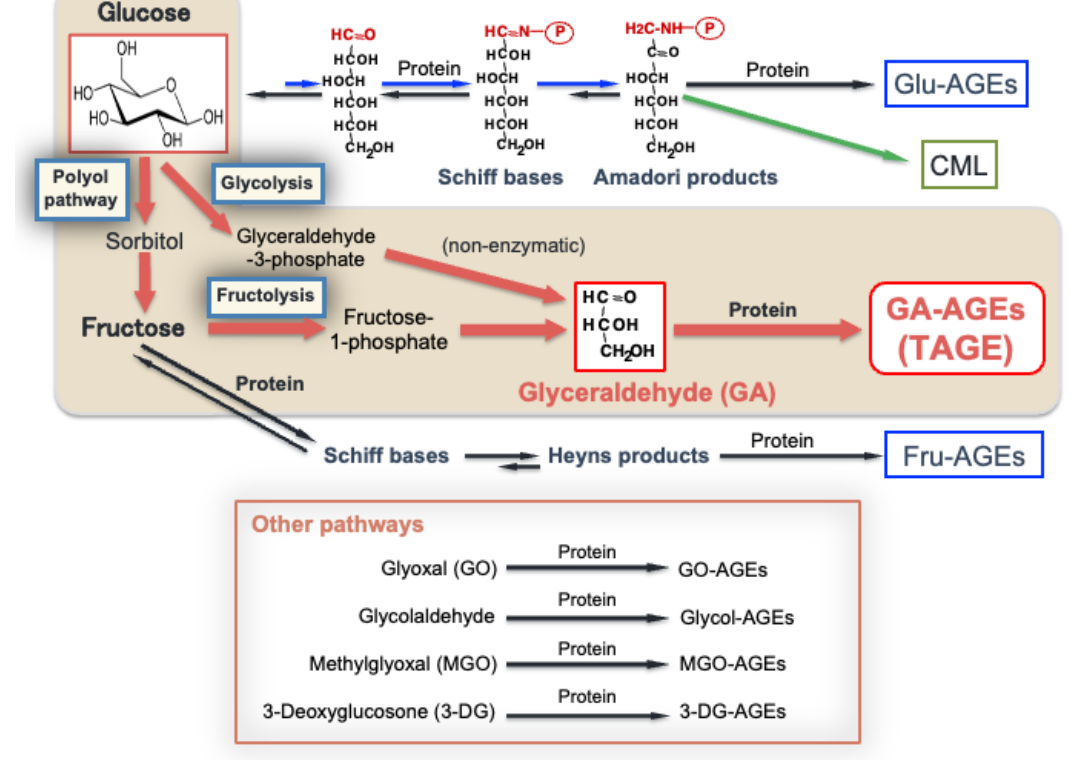
Figure 1. Numerous pathways for the in vivo generation of AGEs. The amino/guanidino groups of proteins and reducing sugars (glyceraldehyde (GA), glucose, and fructose) react in a non-enzymatic manner and produce reversible Schiff ba-